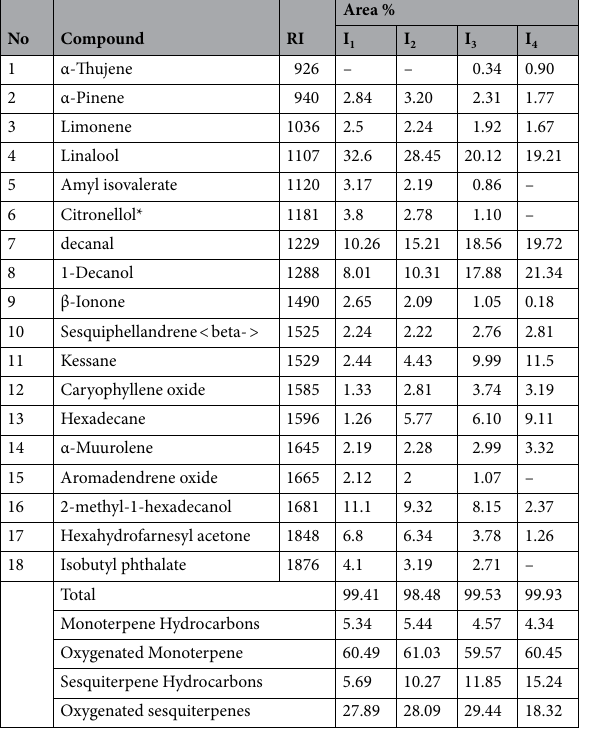
Table 5. Chemical composition of essential oils extracted from Lavandula stricta plants under different irrigation